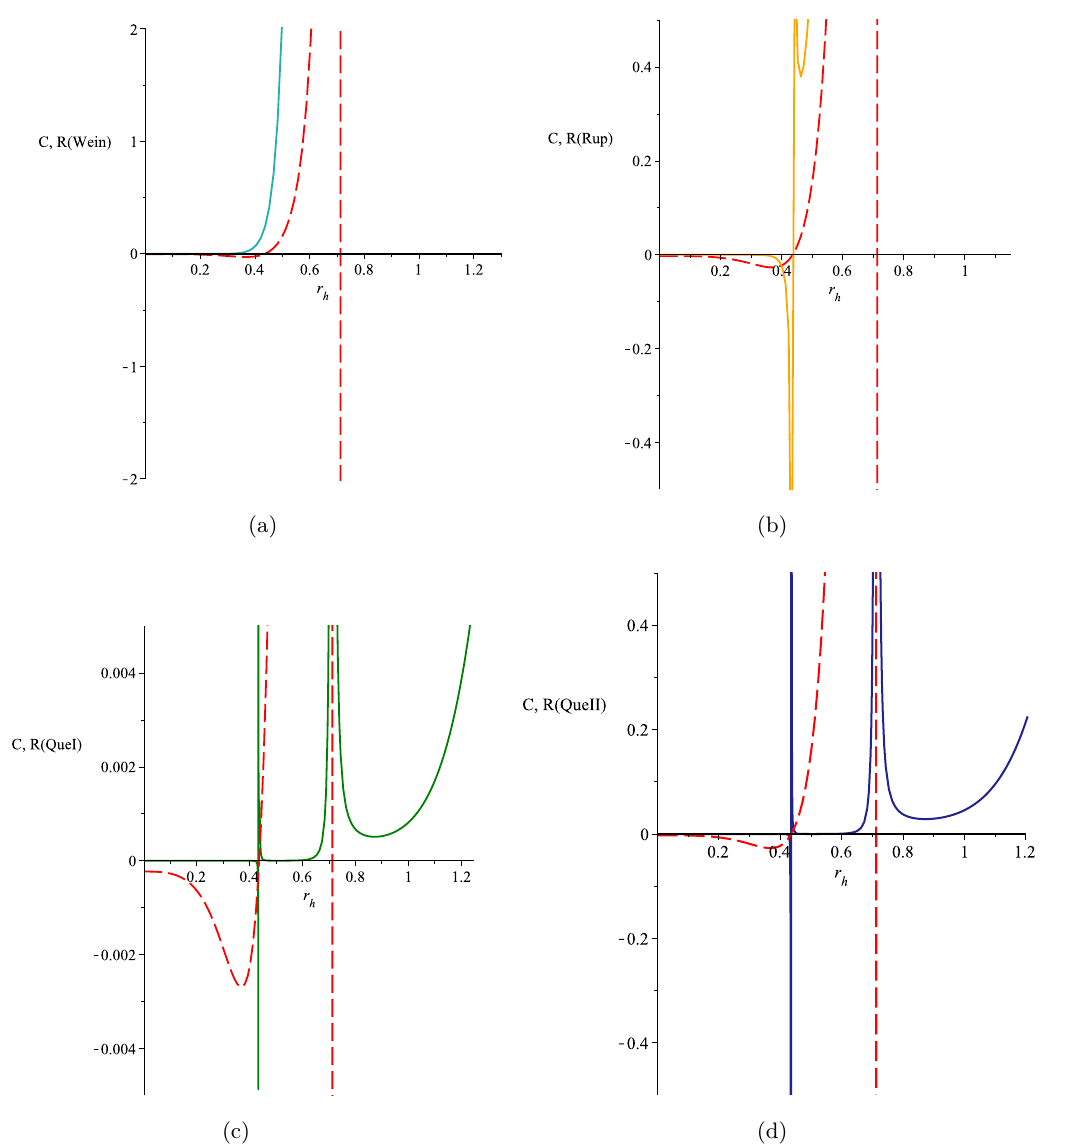
Figure 8 . Curvature scalar variation of Weinhold (light green line), Ruppeiner (orange line), Quevedo case I (green line) and Quevedo case II (navy line) metrics and also specific heat (red dash line), in terms of horizon radius r h for η = 0 . 95 and J = 0 . 01 , for a Myers-Perry black